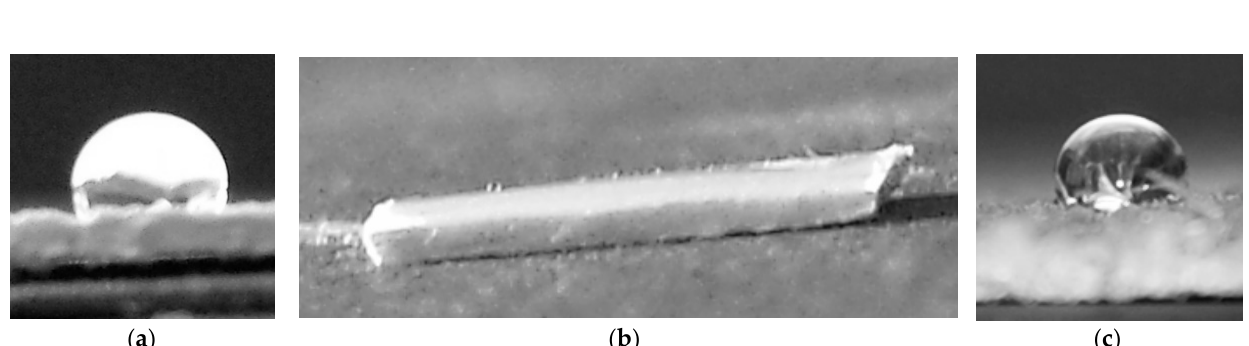
Figure 7. Exemplary water contact angles of the PS sphere coated pine wood sample before ( a ) and after O 2 plasma treatment ( b ), as well as on the uncoated pine wood ( c ).